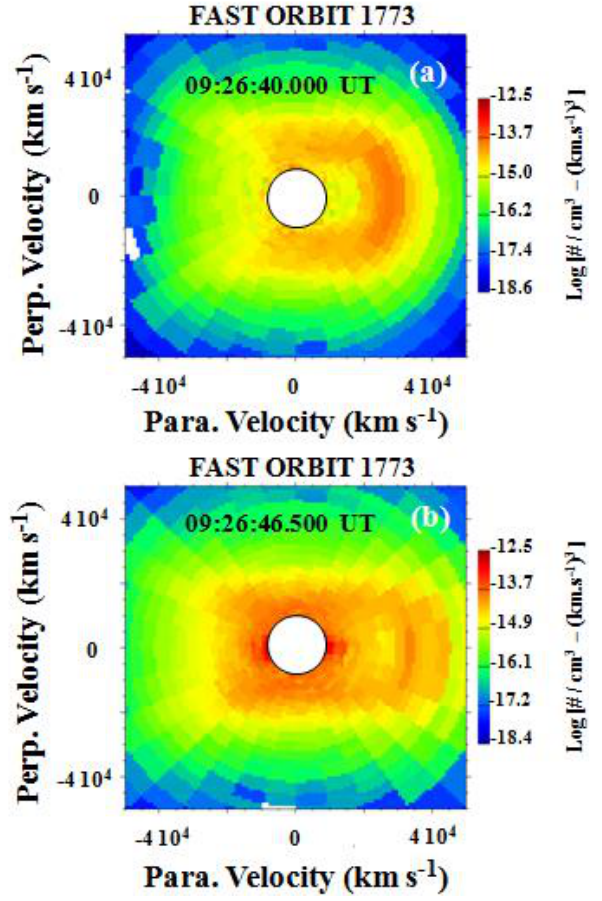
Figure 8. Electron distribution function recorded around 09:26:40UT in the density cavity (a) , incomplete ring dis- tribution with a pronounced beam signature detected around 09:26:46.500UT during the locally enhanced density structure (b) for the FAST orbit 1773. Both distributions are averaged over ∼ 0.8s and the low-energy electron background has been